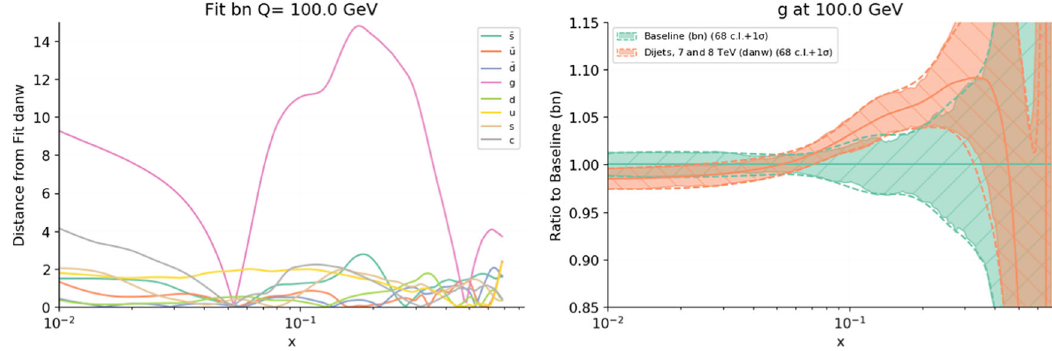
Fig. 13 Same as Fig. 6, but now for dijets